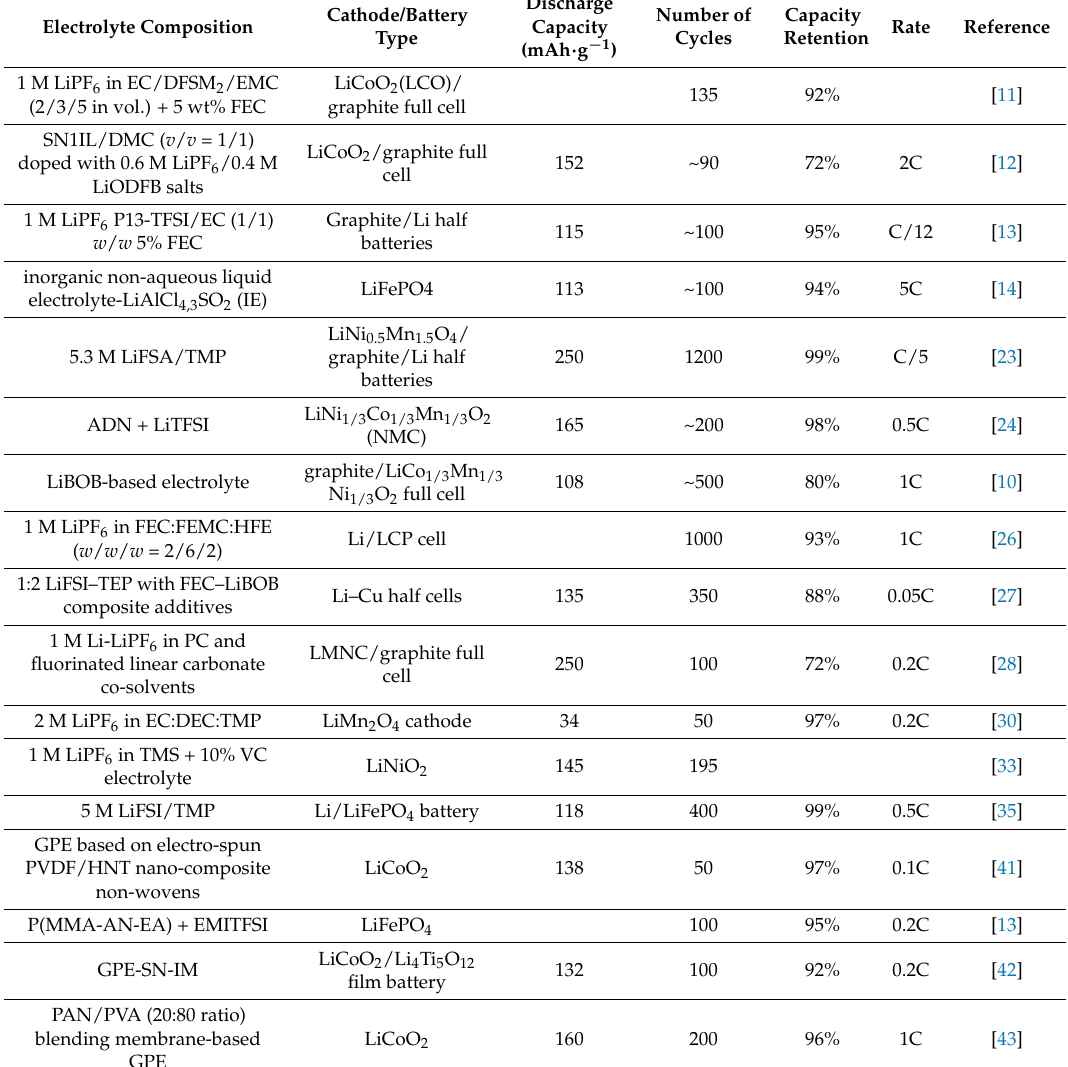
Table 1. Summary of non-flammable electrolytes and their electrochemical performance. Electrolyte